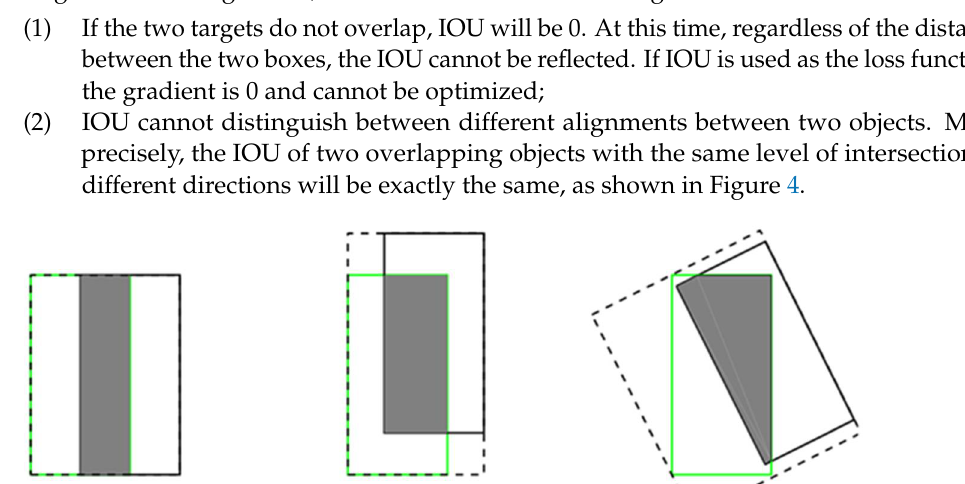
Figure 3. Schematic diagram of the sliding vertex box definition method.